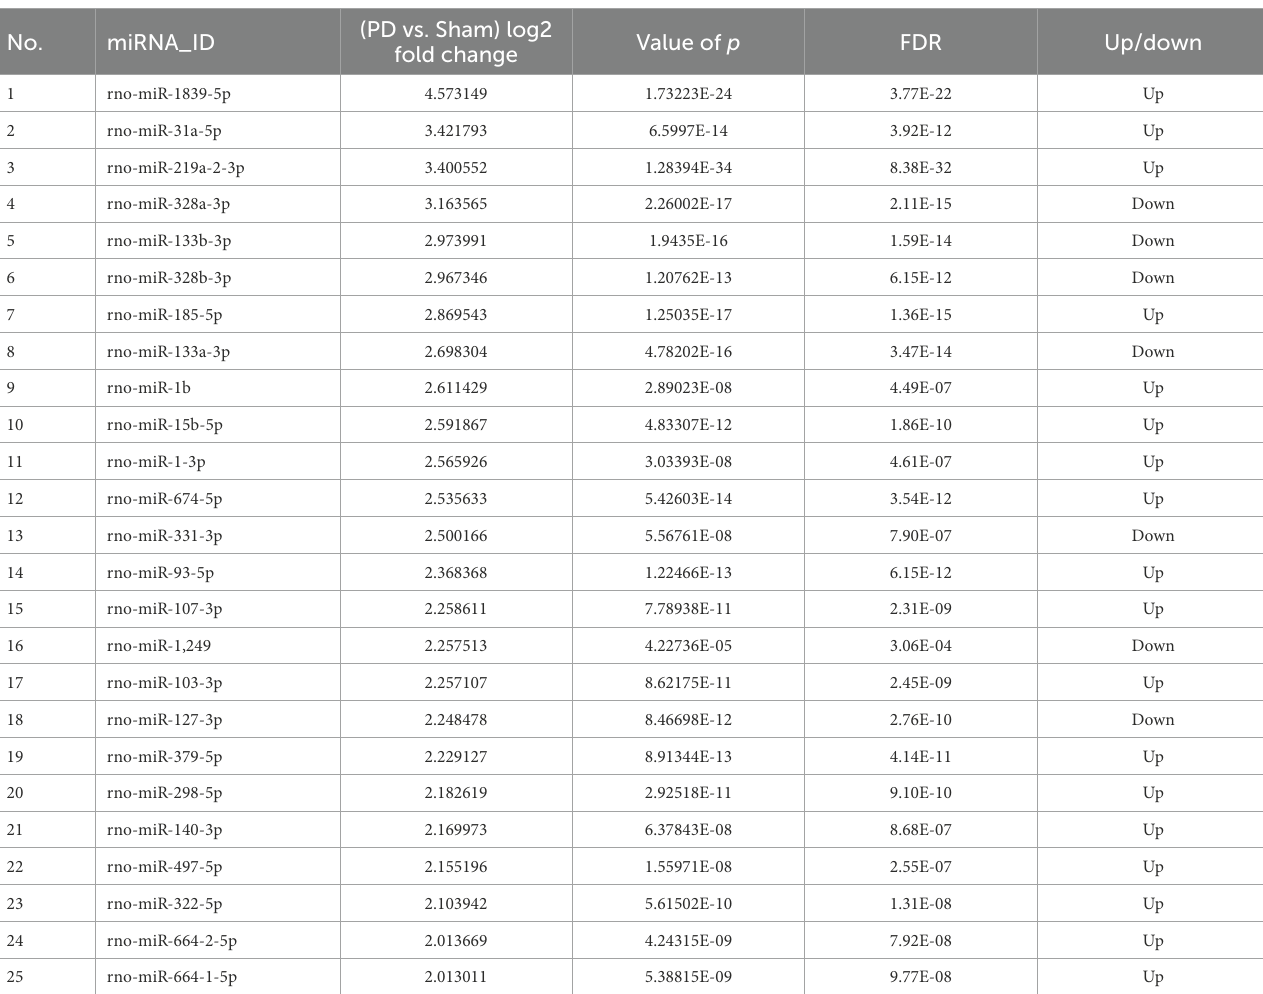
TABLE 1 Top 25 differentially expressed microRNAs